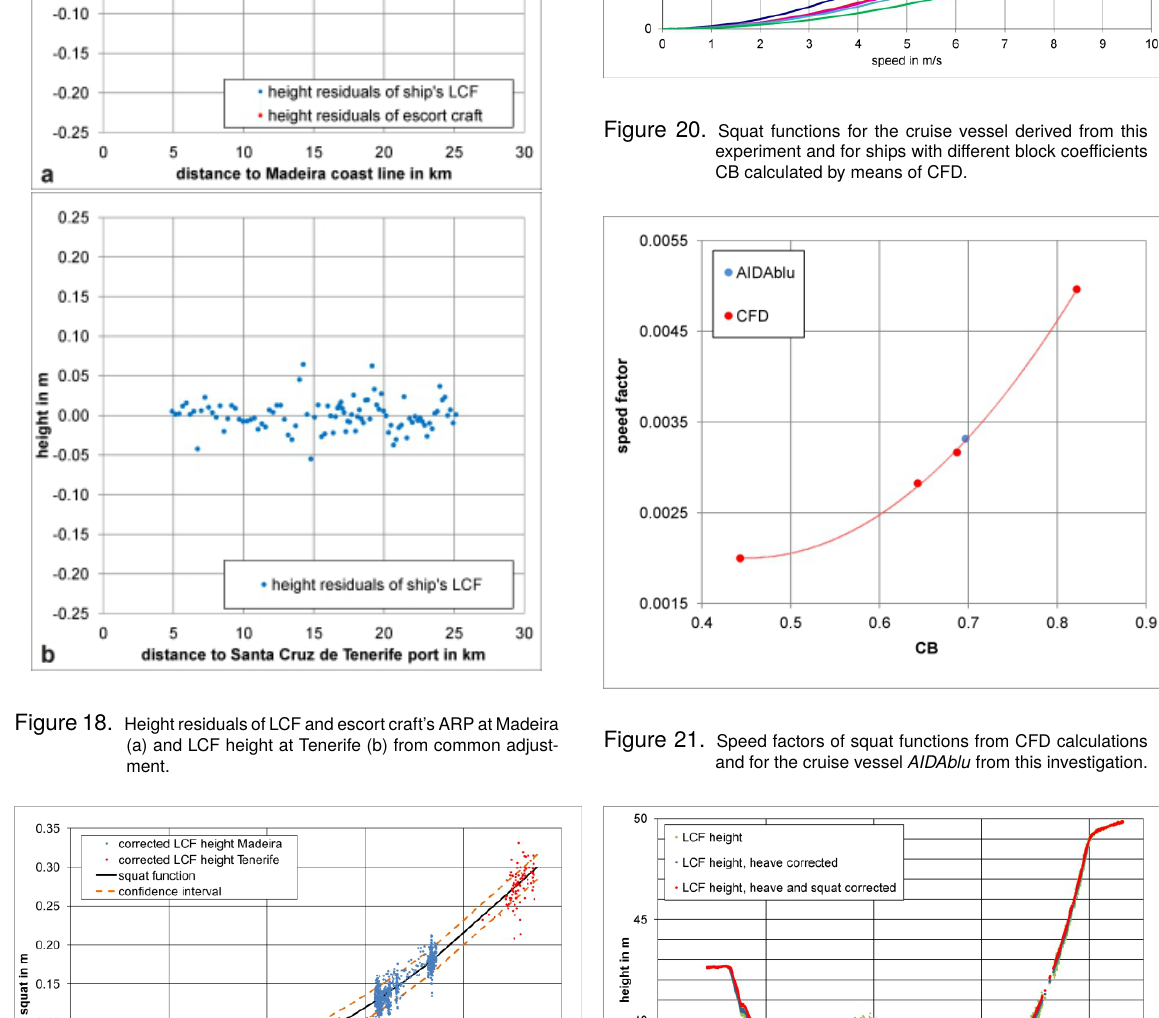
Figure 22. LCFheightbetweenTenerifeandMadeiraalongthetrack of the cruise vessel. The fully corrected LCF height rep- resents the instantaneous